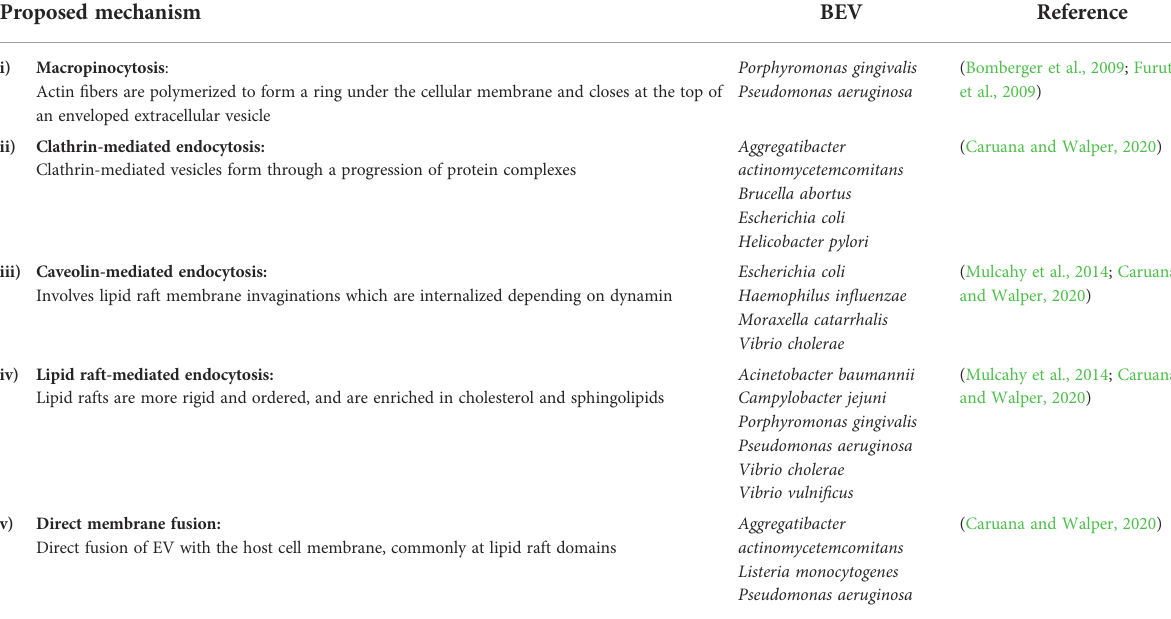
TABLE 4 The uptake of BEV by host cells through proposed mechanisms.